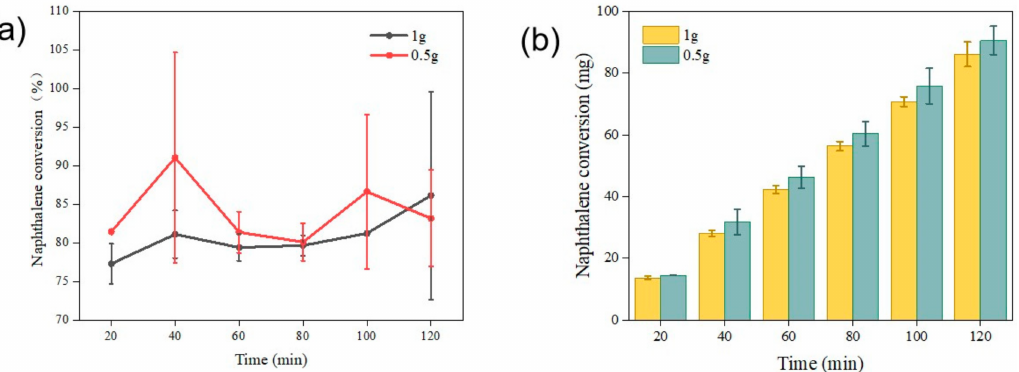
Figure 7. The Naphthalene conversion ( a ) rate (%) and ( b ) amount (mg) with different space velocity ratios on tar catalytic reforming in 2